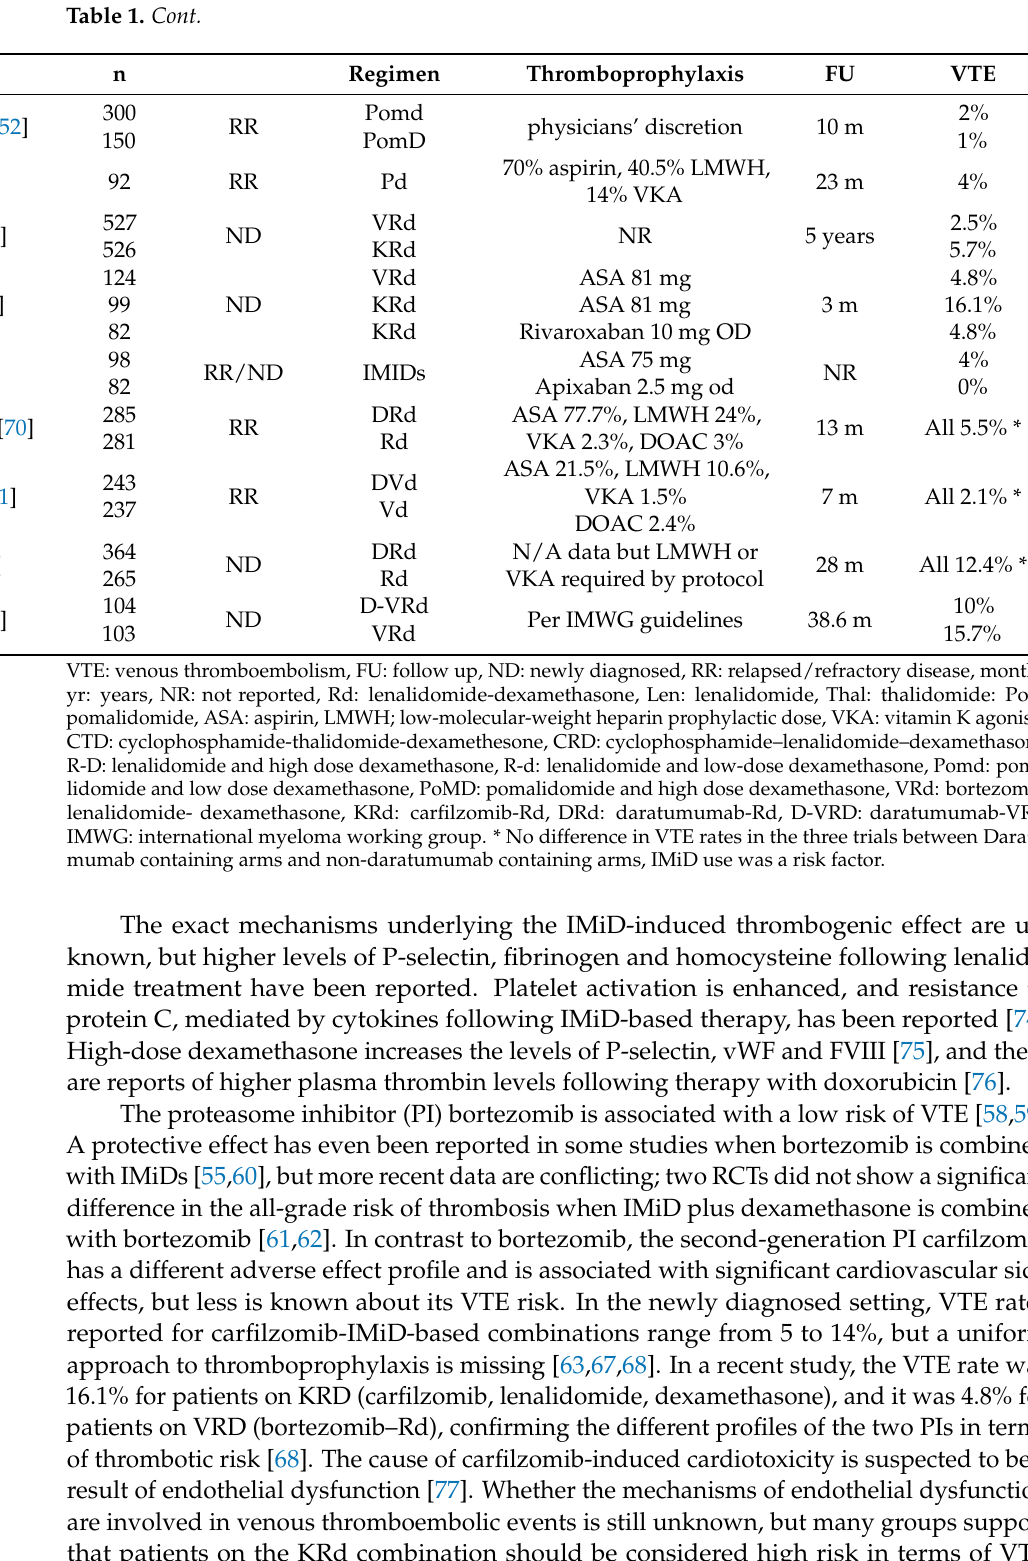
difference in the all-grade risk of thrombosis when IMiD plus dexamethasone is combined with bortezomib [61,62]. In contrast to bortezomib, the second-generation PI carfilzomib has a different adverse effect profile and is associated with significant cardiovascular side effects, but less is known about its VTE risk. In the newly diagnosed setting, VTE rates reported for carfilzomib-IMiD-based combinations range from 5 to 14%, but a uniform approach to thromboprophylaxis is missing [63,67,68]. In a recent study, the VTE rate was 16.1% for patients on KRD (carfilzomib, lenalidomide, dexamethasone), and it was 4.8% for patients on VRD (bortezomib–Rd), confirming the different profiles of the two PIs in terms of thrombotic risk [68]. The cause of carfilzomib-induced cardiotoxicity is suspected to be a result of endothelial dysfunction [77]. Whether the mechanisms of endothelial dysfunction are involved in venous thromboembolic events is still unknown, but many groups support that patients on the KRd combination should be considered high risk in terms of VTE risk